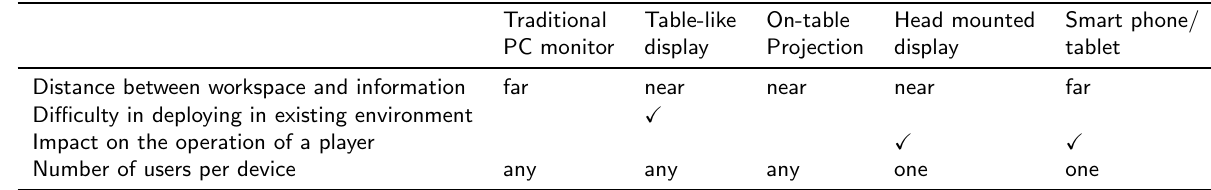
Table 1. Characteristics of presentation devices Table-like